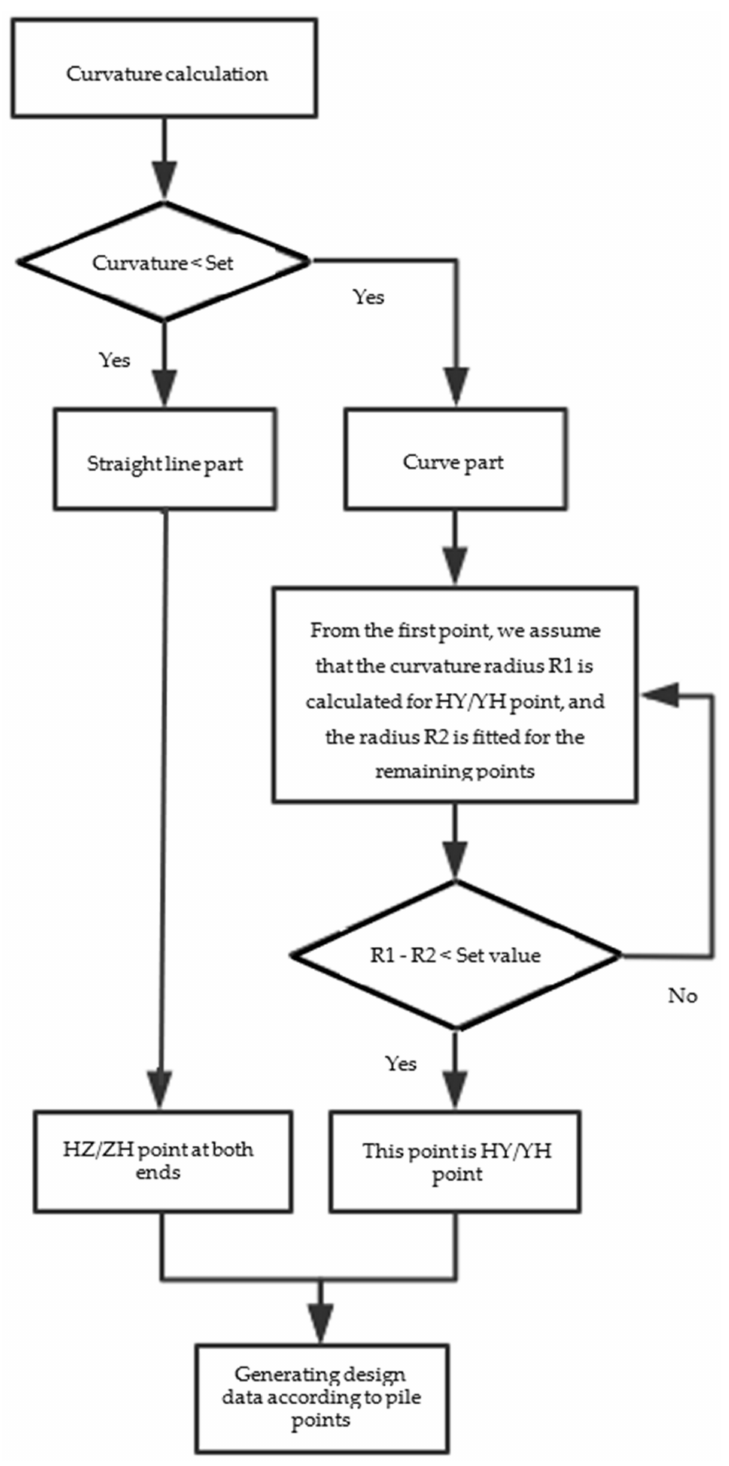
Figure 4. Flow chart of design data generated by curvature